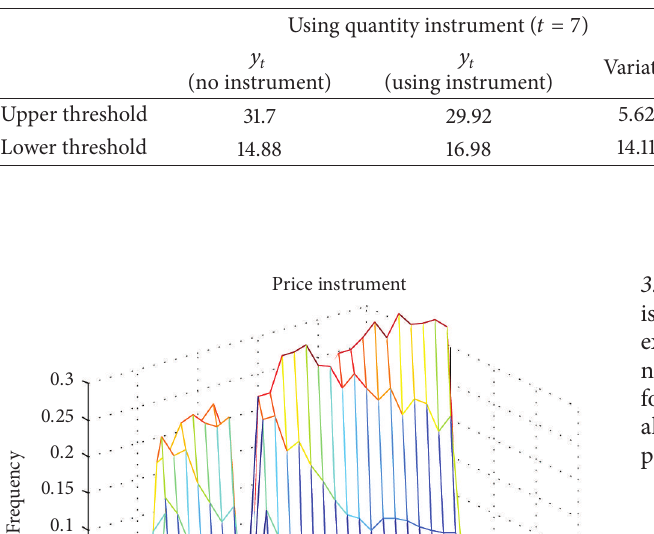
Table 1: Upper and lower threshold regulations comparative.